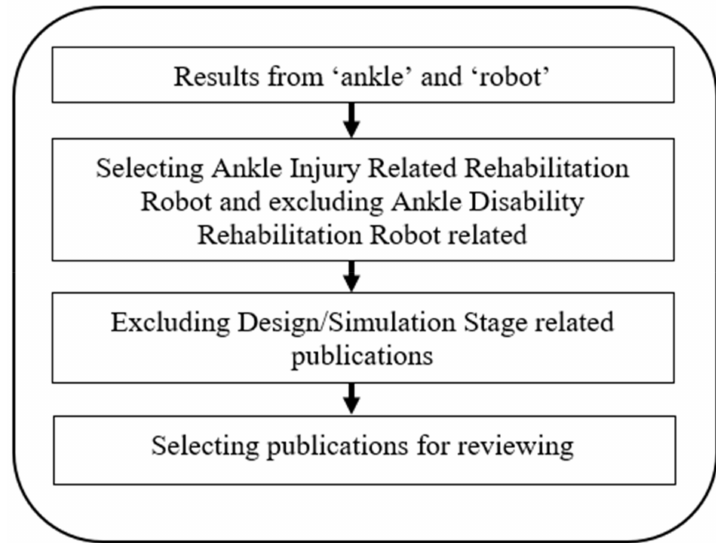
Figure 2. The flow of the selection reviewing